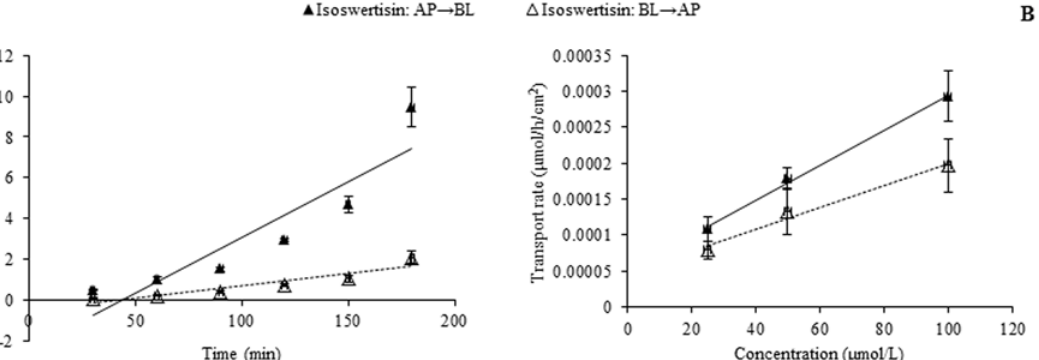
Fig 3. Transport of isoswertisin across Caco-2 cell monolayer. Notes: (A) The percent transport of isoswertisin as a function of time at 50 μ mol/L; (B) The transport rate of isoswertisin as a function of concentration at 90 min.